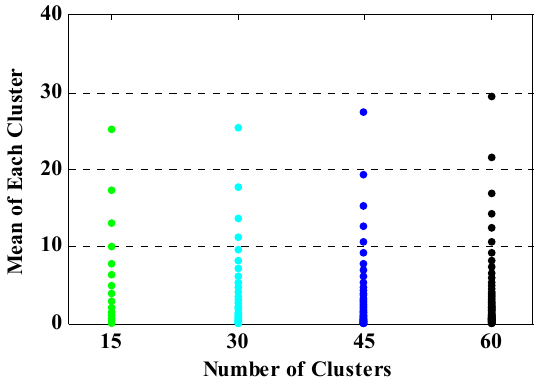
Figure 6. Center of clusters after convergence achieved in data clustering.